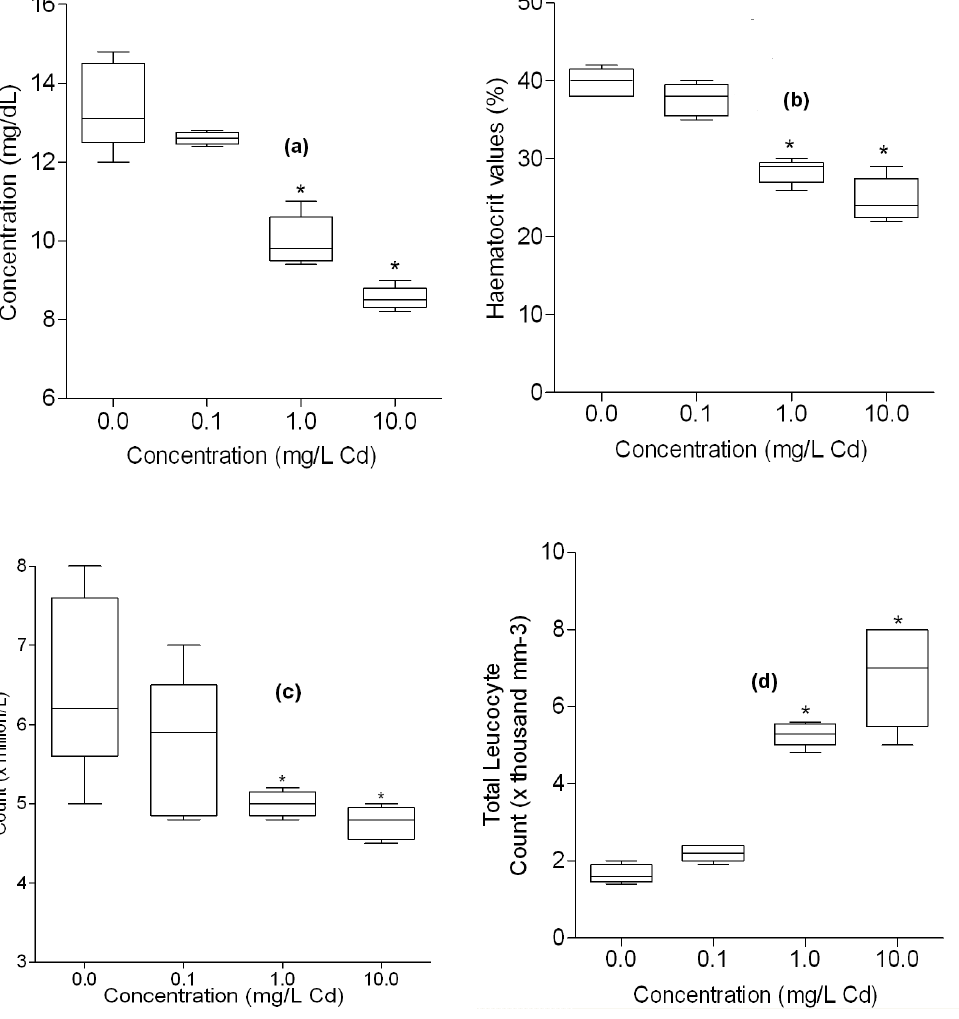
Fig. 1. Alteration in haemoglobin (a), haematocrit (b), total erythrocyte count (c) and total leucocyte count (d) in Parachanna